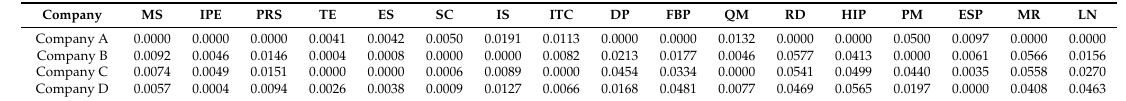
Table 7. The distance between the ideal solution.